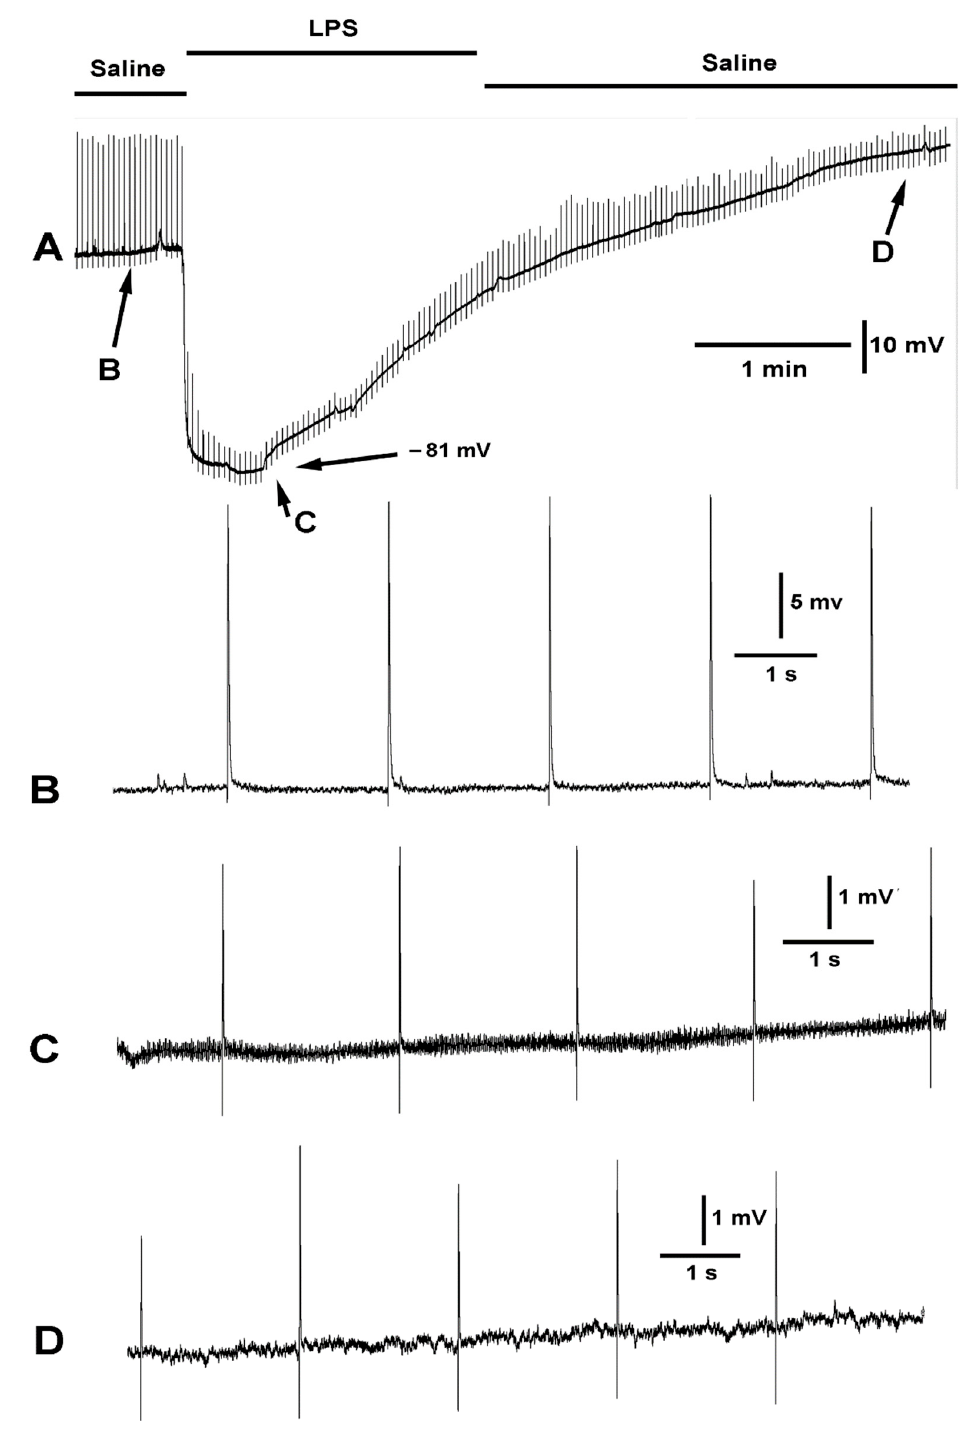
Figure 8. The effect of LPS on evoked synaptic transmission and resting membrane potential. The segmental nerve was stimulated at a rate of 0.5 Hz. ( A ) The overall effect on the membrane potential and the amplitude of the EJPs is shown. Note the membrane potential started to repolarize while still exposed to LPS. ( B ) The EJPs and mEJPs were observed in saline. ( C ) Exposure to LPS rapidly hyperpolarized the membrane and reduced the amplitude of the evoked EJPs and the mEJPs. The mEJPs can no longer be observed. Despite the increased driving force for increased amplitude of the EJPs and mEJPs they were greatly reduced in amplitude. ( D ) When the bath was exchanged to fresh saline, the membrane regains the initial value and the amplitude of the evoked EJPs increased.